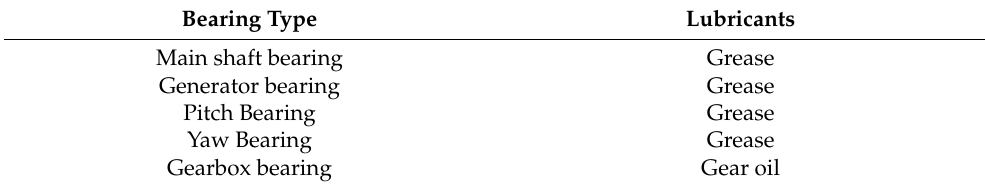
Table 4. Lubricants for wind turbine bearings (Adapted from [83,84]).